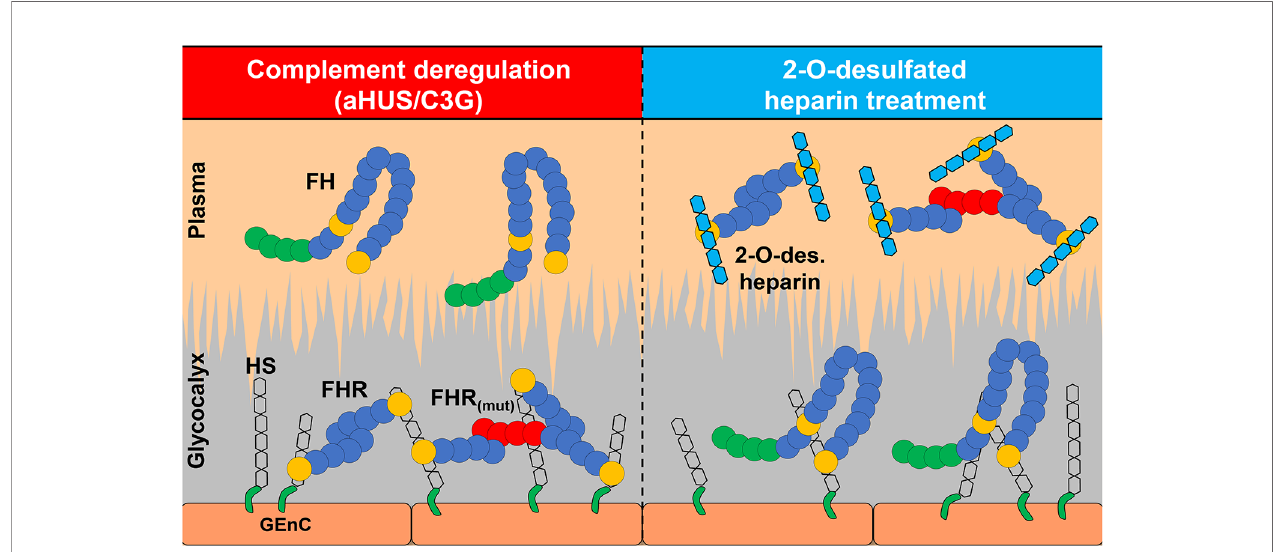
FIGURE 5 | 2-O-desulfated heparin oligosaccharides are potential therapeutics for C3G and other diseases with dysregulated complement. Pathogenic changes in complement components or glomerular glycocalyx affect the balance between FH and FHRs contributing to disease development. 2-O-desulfated heparin derivatives selectively inhibit FHR1 and FHR5 binding to glomerular endothelium without affecting FH binding, which makes them potential therapeutics for C3G and other diseases with dysregulated